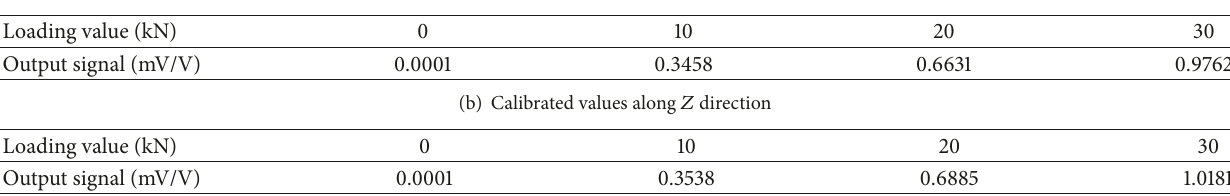
Table 6: Calibrated values of sensor output corresponding to forces acting on plane support plate pin shaft along the 𝑌 and 𝑍 directions.